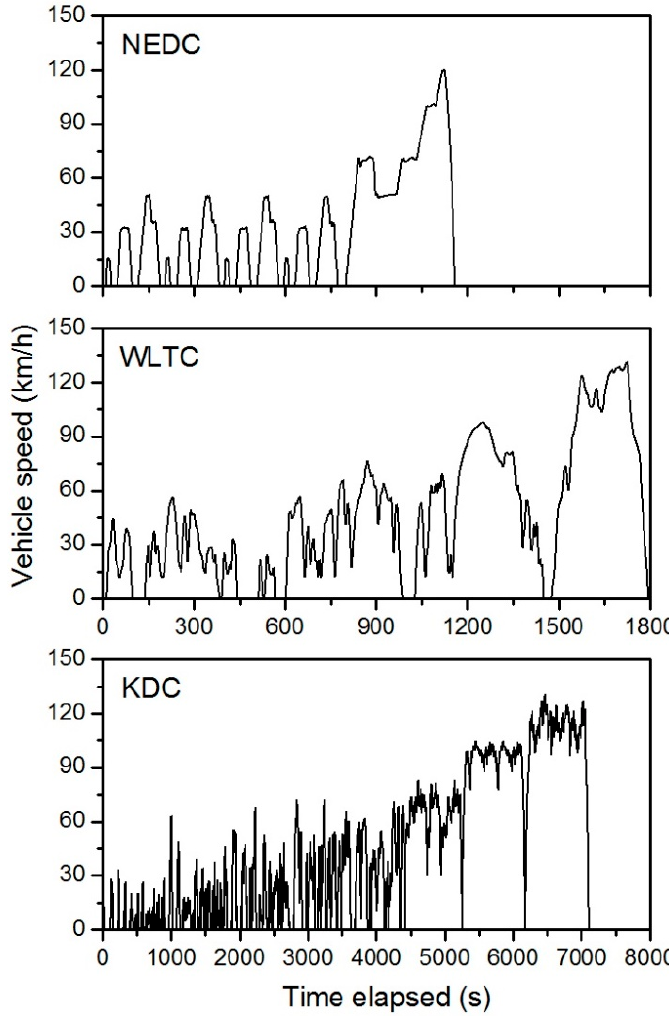
Figure 2. Driving profiles for laboratory emission tests. NEDC: New European Driving Cycle; WLTC: worldwide harmonized light-duty test cycle; KDC: Korea Driving Cycle.